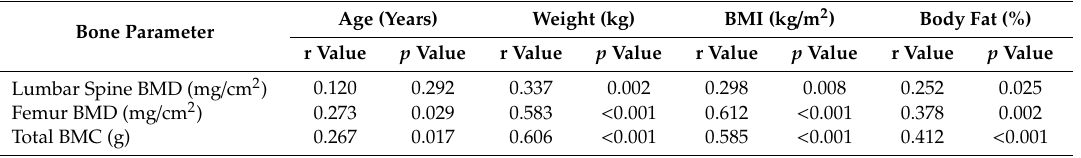
Table 5. Correlations between age and adiposity and lumbar spine and femur bone densitometry assessed by DXA of Brazilian women living in Brazil by age tertiles ( n = 79) 1 .